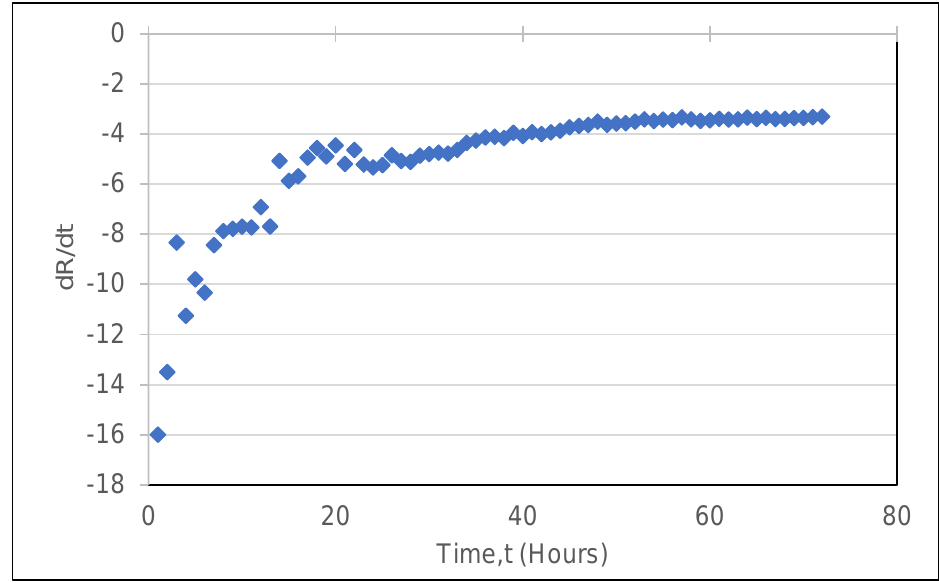
Figure 17. The graph showing the rate of change of corrosion per hour throughout the test.